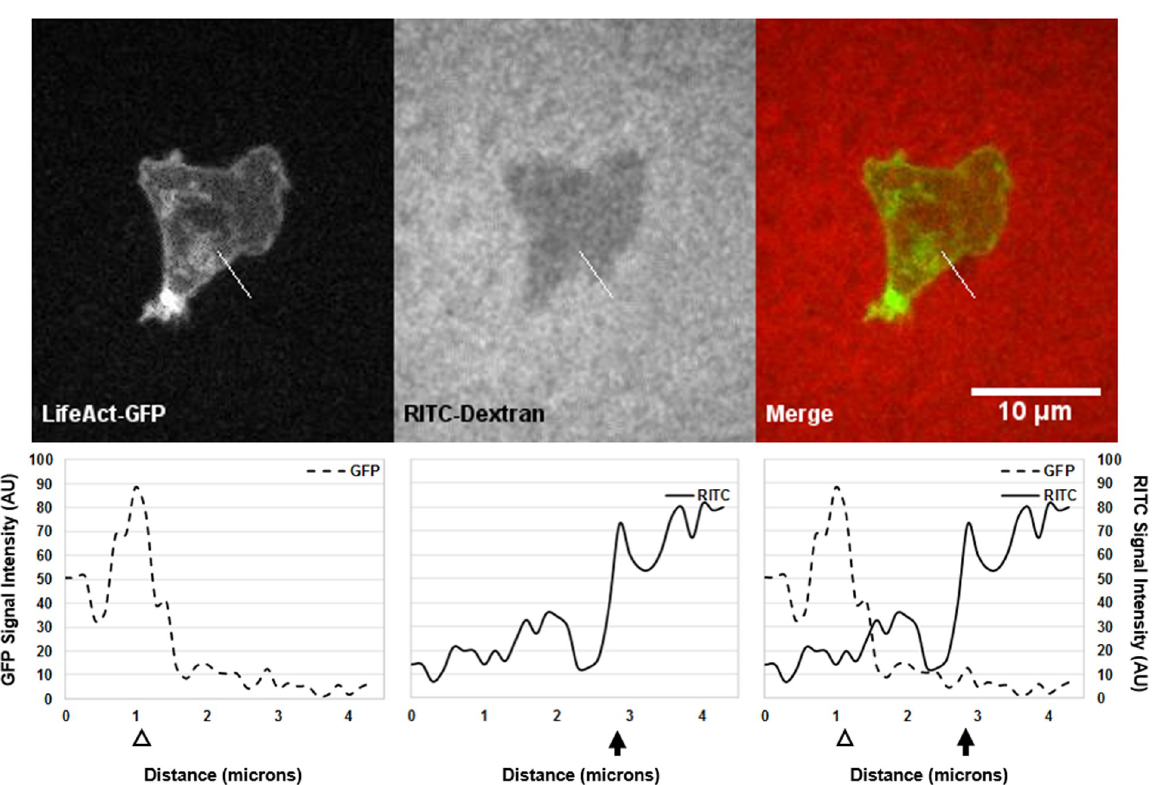
Fig 3. ImageJ intensity plots quantitatively confirm membrane and cortex positions of a putative bleb. A single time point of a wild-type cell crawling under 0.5 percent agarose gel from Fig 2 with respective intensity plots of the signals along the drawn line (white line) for each channel is shown. Left, the LifeAct-GFP signal (dashed line) indicated the cortex’s position (white arrowhead) at 1.1 microns. Center, the RITC-Dextran signal (solid line) indicated the membrane’s position (black arrow) at 2.9 microns where the cell’s membrane ends and the agarose begins. Right, the merge of the two channels shows membrane detachment from the cortex by a distance of 1.8